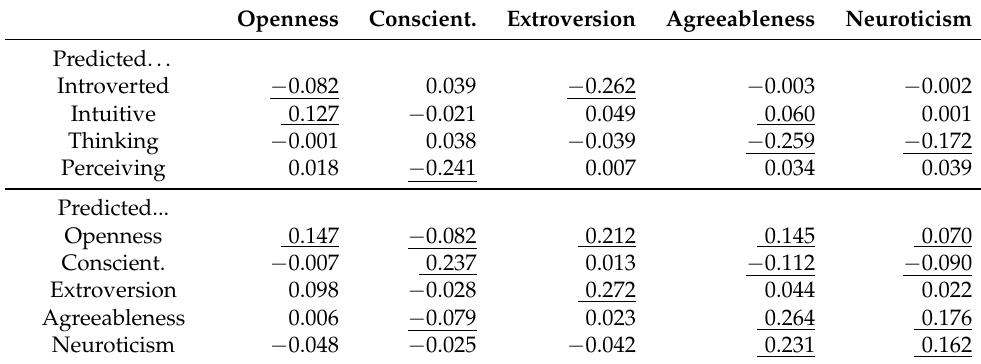
Underlined numbers indicate significant correlation ( p <